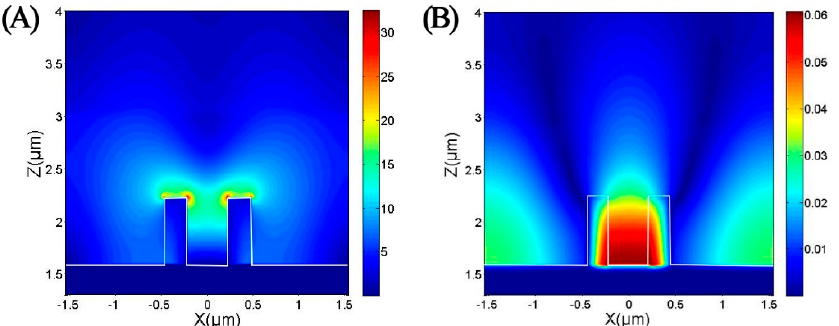
Figure 4. The distribution of electric field ( A ) and magnetic field ( B ) on the XOZ section at λ =3750 nm of the symmetric Si grating. The grating is outlined with white lines.